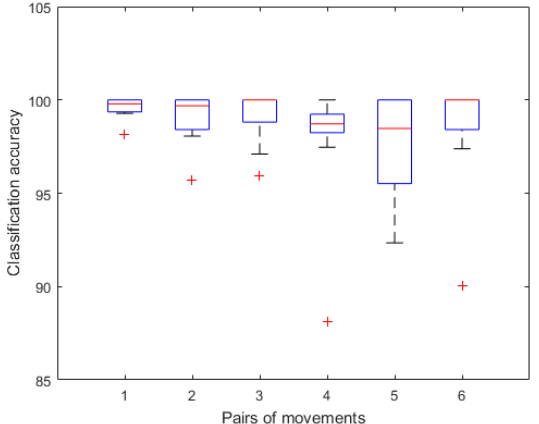
Figure 8. Boxplot for EMG tasks classification accuracy with ECU and ECR. The horizontal axis represents the different pairs of movements (1: REST vs. MF, 2: REST vs. WE; 3: REST vs. WF, 4: MF vs. WE, 5: MF vs. WF, and 6: WE vs. WF).